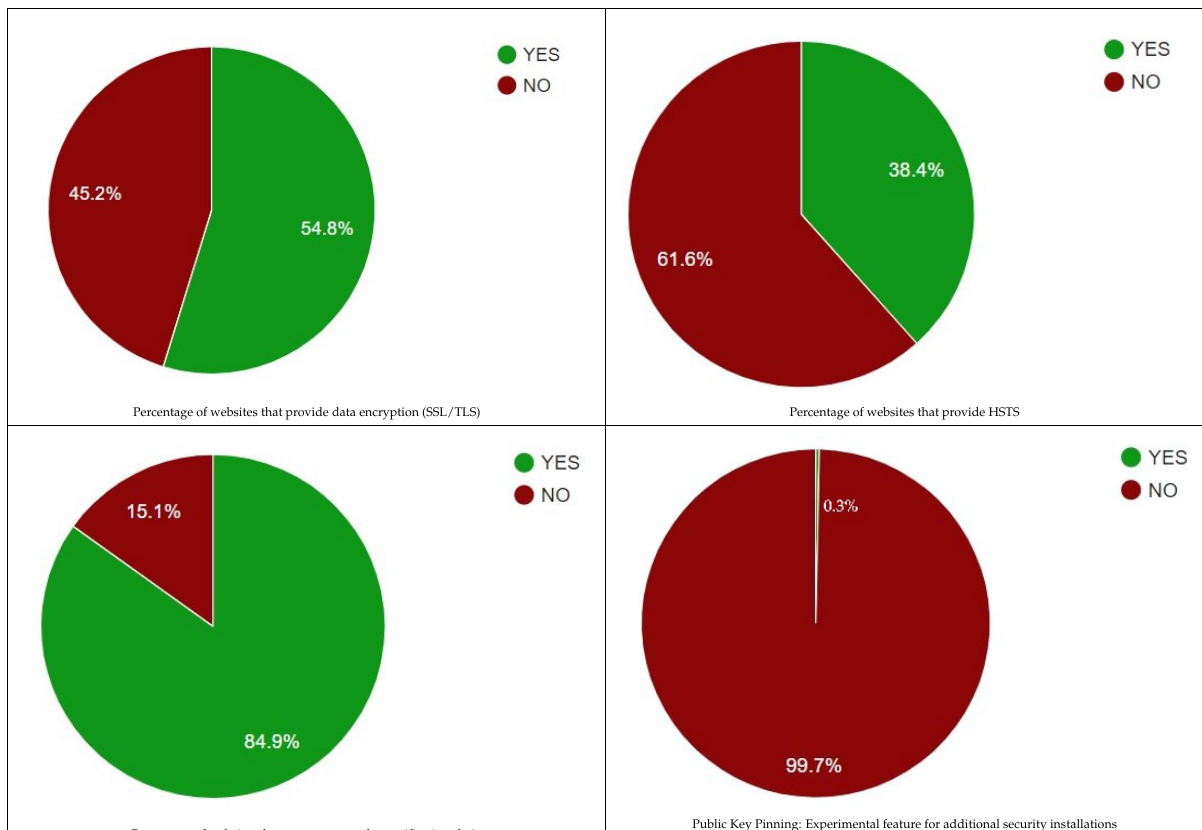
Figure 4. Example of the graphical information provided for the confidentiality